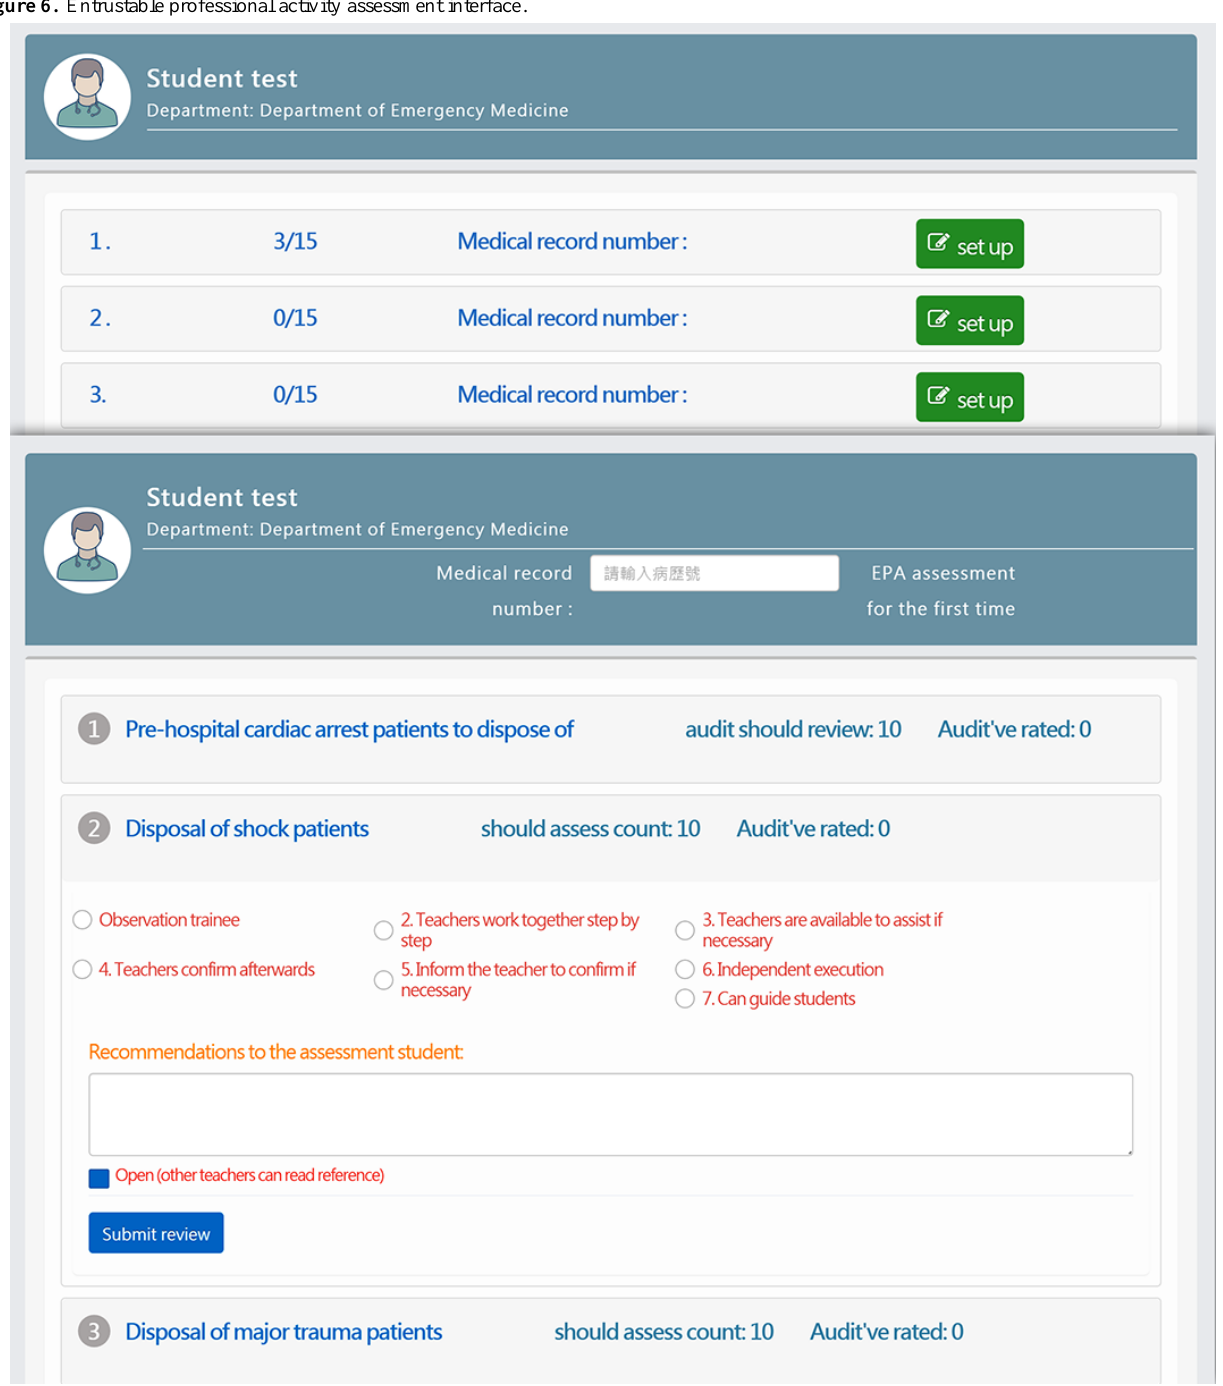
Figure 6. Entrustable professional activity assessment